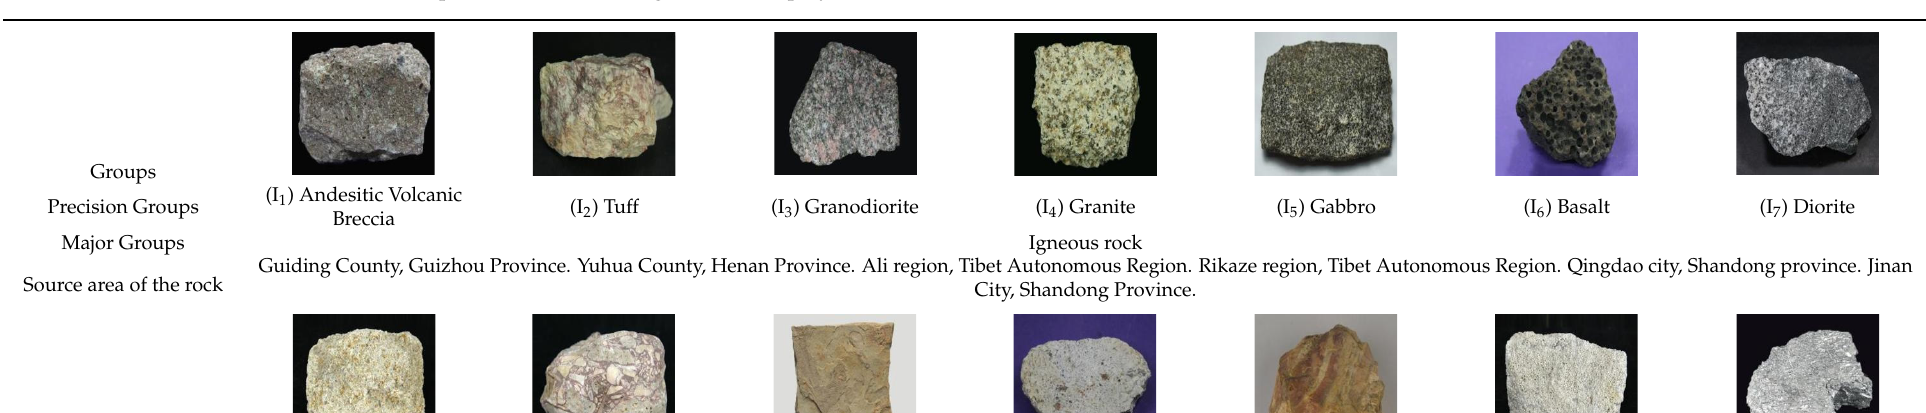
Table 1. Representative rock image dataset display.